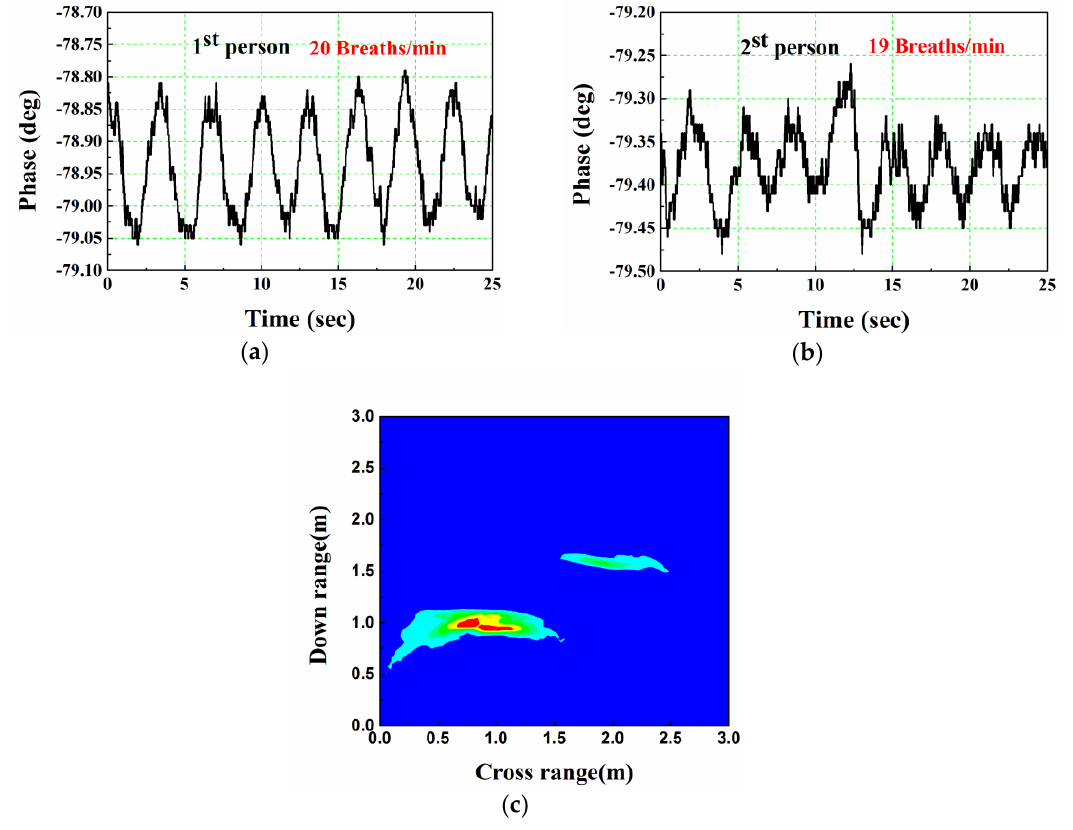
Figure 10. Human detection and imaging result for two human located at (0.8, 1.0) m and (2.0, 1.5) m, respectively. ( a ) Vital sign data of 1st human; ( b ) Vital sign data of 2nd human; ( c ) Two-dimensional imaging result.